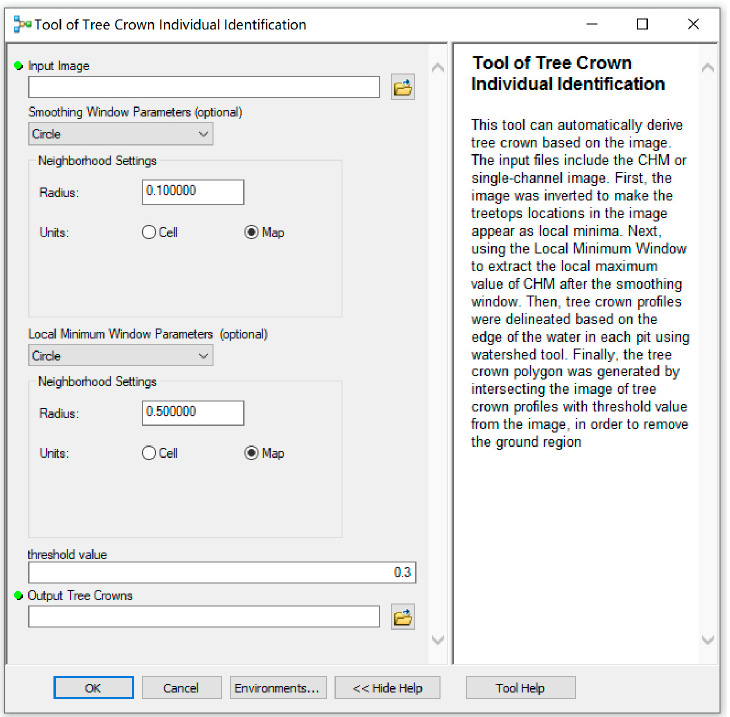
Figure A4. A visual modeling environment using the MCWS algorithm for individual tree detection.